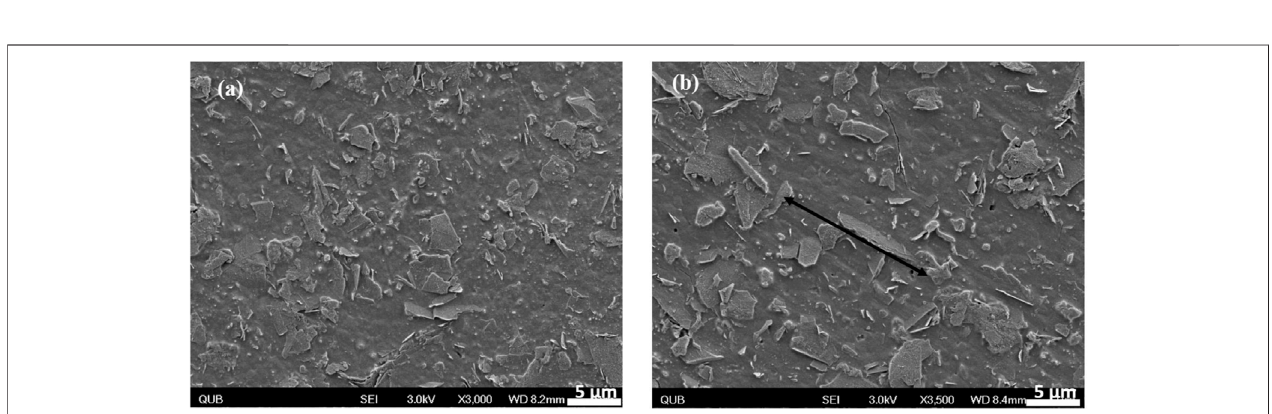
FIGURE 4 | SEM images of plasma etched (A) unstretched PP/GNP 5% M-5 and (B) the demonstrator part.